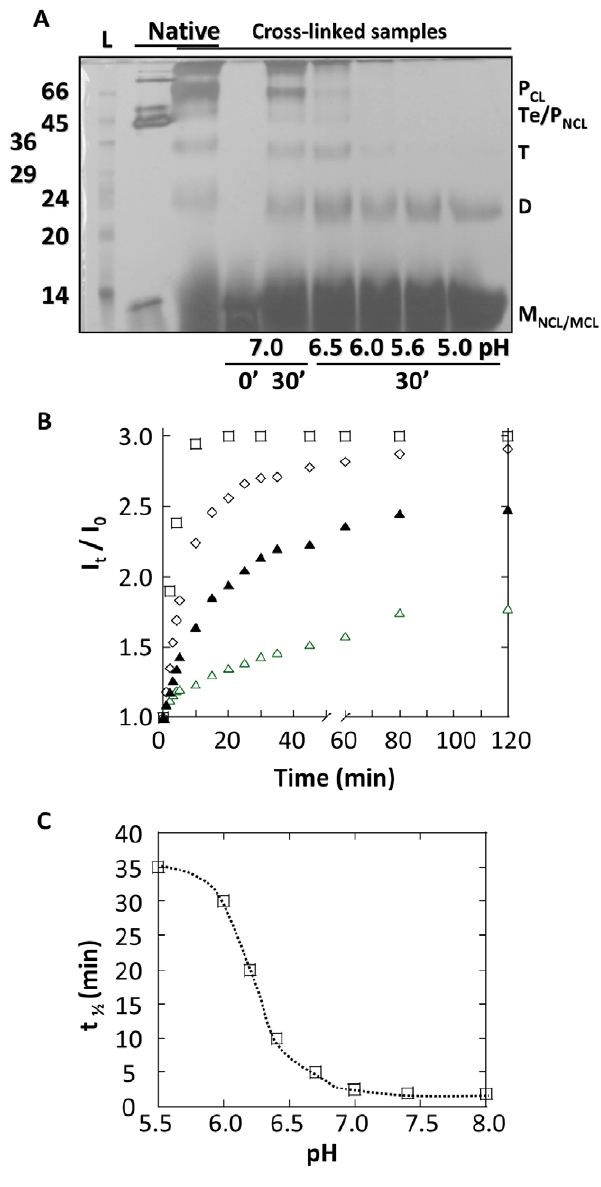
Figure 4. Formation of CtxB intermediates as function of pH. CtxB 5 was treated for 15 min at pH 1.0 and subsequently diluted to a final concentration of 8.6 m M in McIlVaine buffers at indicated pH. The samples were incubated for 30 min at 23 u C. A. Determination of the CtxB intermediates by cross linking and SDS PAGE. Immediateley after neutralization or 30 min later, the samples were cross-linked with glutaraldehyde for 2 min prior mixing with 4 6 sample buffer and subsequent analysis by SDS-PAGE. Cross-linked CtxB Pentamer (P CL ) and stoechiometric intermediates (D, dimer; T, trimer; Te, tetramer) as well as cross-linked CtxB monomer (M CL ) were identified on the gel. Native CtxB 5 cross-linked (P CL ) and not cross-linked (P NCL ) were also loaded on the gel to identify their respective position. L stands for the apparent molecular weights of standards, indicated in kDa. B. Time-dependent changes in the intensity of the Trp-fluorescence maxima of the samples were measured, immediately after dilution into the cuvette containing McIlVaine buffer at indicated pH, and for 30 min. The ratio of the fluorescence intensity at‘t’ by the fluorescence intensity at t=0 (just after addition of the sample into the cuvette) was plotted against time for comparison purpose. Reassembly is monitored for pH 7.0 ( % ), 6.7 ( e ); 6.2 ( m ) and 5.9 ( D ). C. Half-times of the reassembly reactions at indicated pH, calculated from the increase of the Trp-fluorescence intensity were plotted against